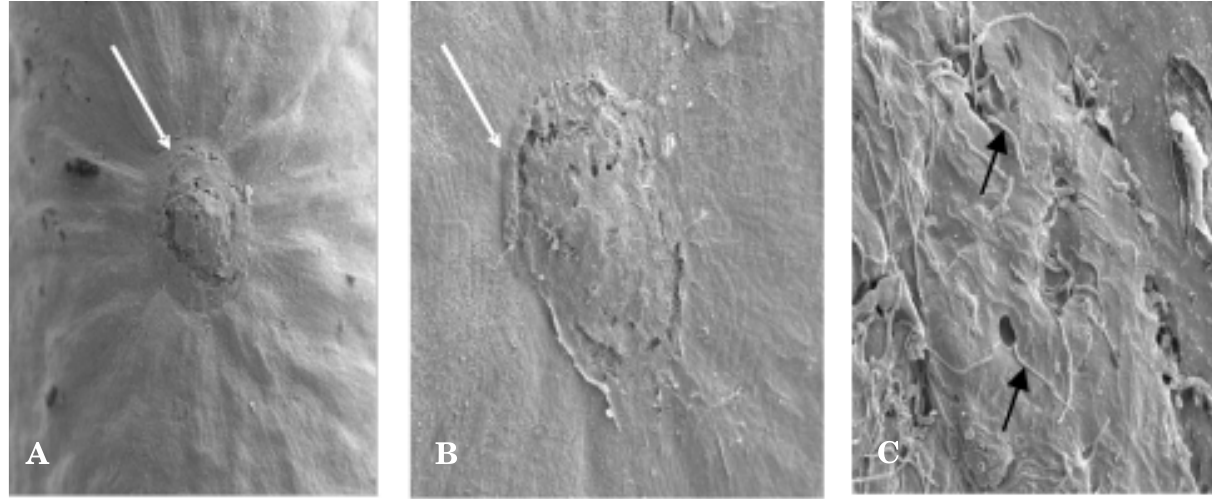
.Fig. 3. Scanning electron micrographs of the surface of grape berries cv. Chardonnay showing the lenticel area (white arrows). A. Control. B. Inoculated with Pm. aleophilum P99.4, 72 h after inoculation. C. Enlarged portion of the inoculated lenticel showing hyphae entering cracks in the lenticel (black